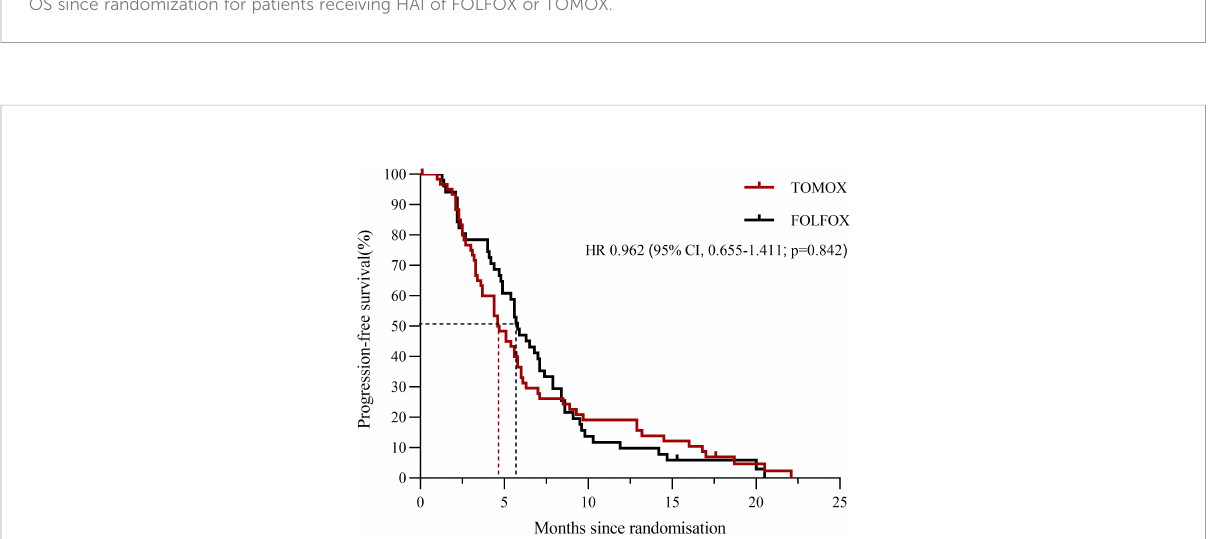
FIGURE 3 PFS since randomization for patients receiving HAI of FOLFOX or TOMOX.